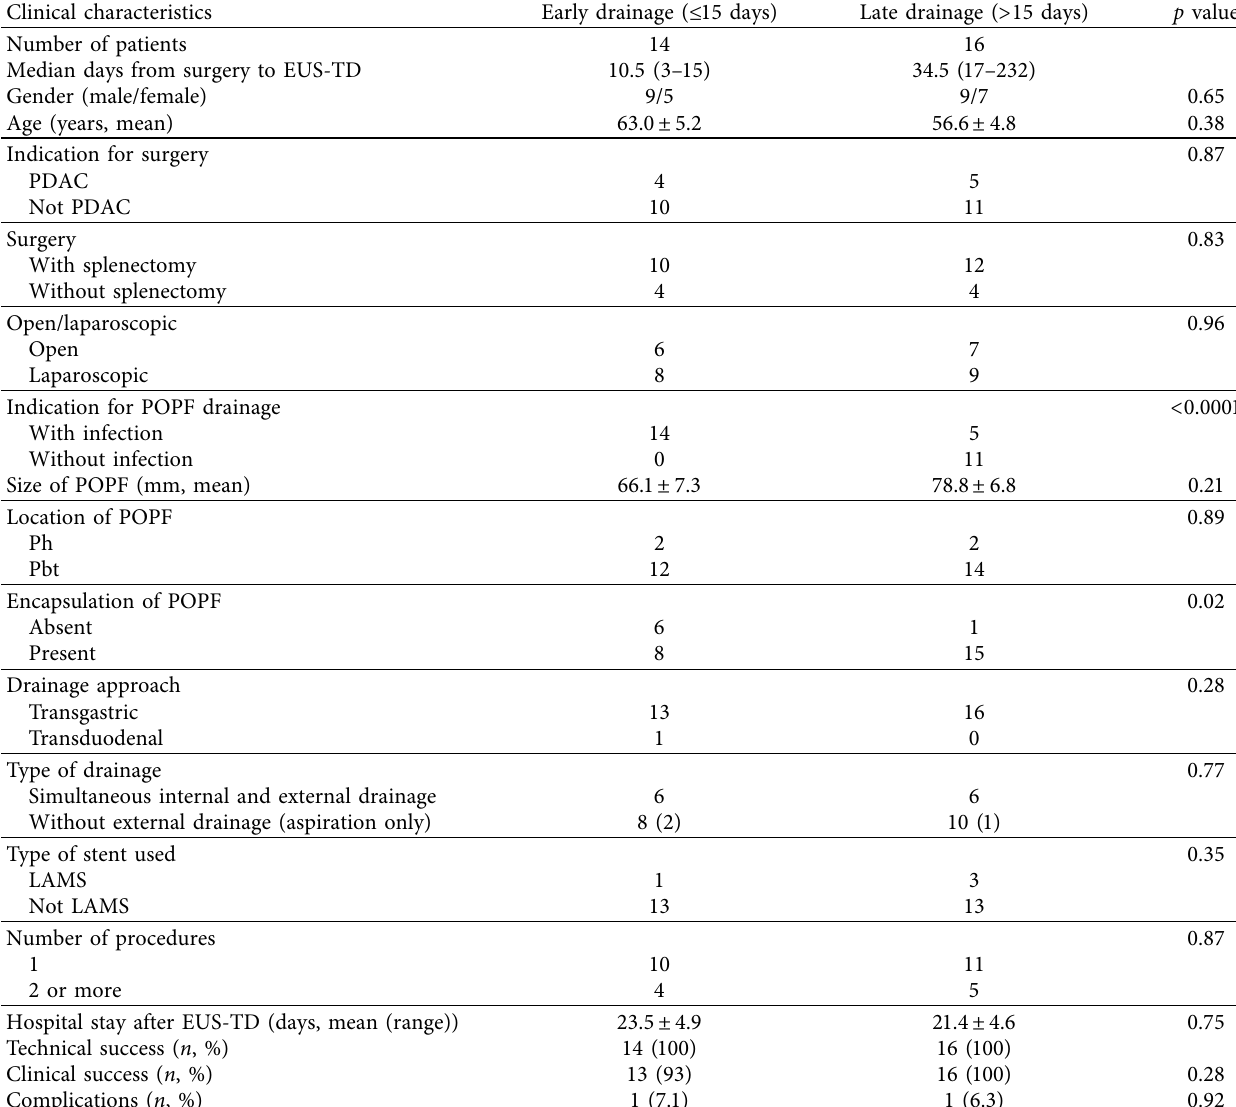
Table 2: Comparison of clinical characteristics between the early and late drainage patient